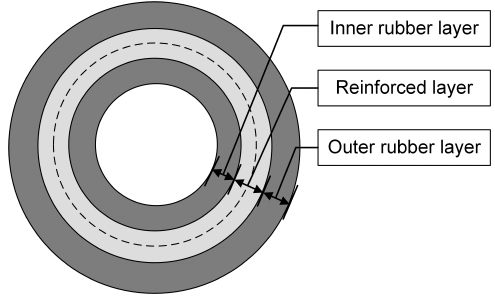
Figure 1: The cross-section of the fiber reinforced rubber